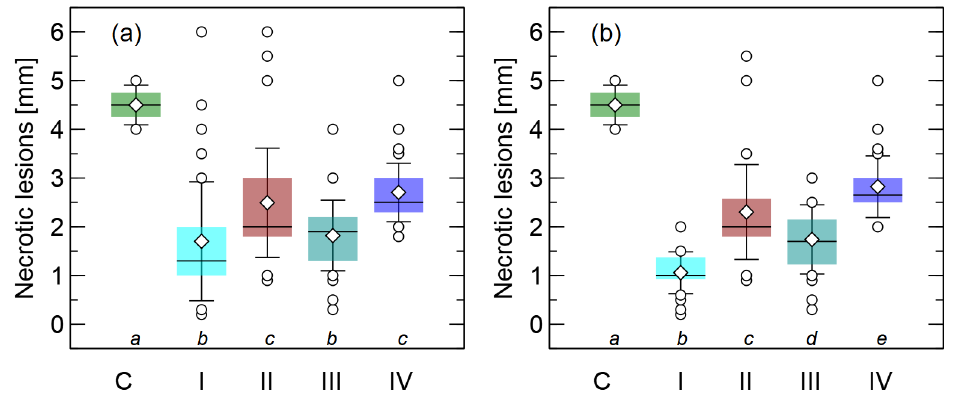
Figure 3. Necrosis lengths for the four treatments of extracts application (I—IV) and control (C). In panel ( a ), all measured samples are presented, in ( b ), samples for which the extract of Fomitopsis pinicola was applied have been excluded. Treatments, for which a statistically significant difference at p < 0.05 was found using Tukey’s multiple comparisons test, are marked by different characters in the bottom part of the